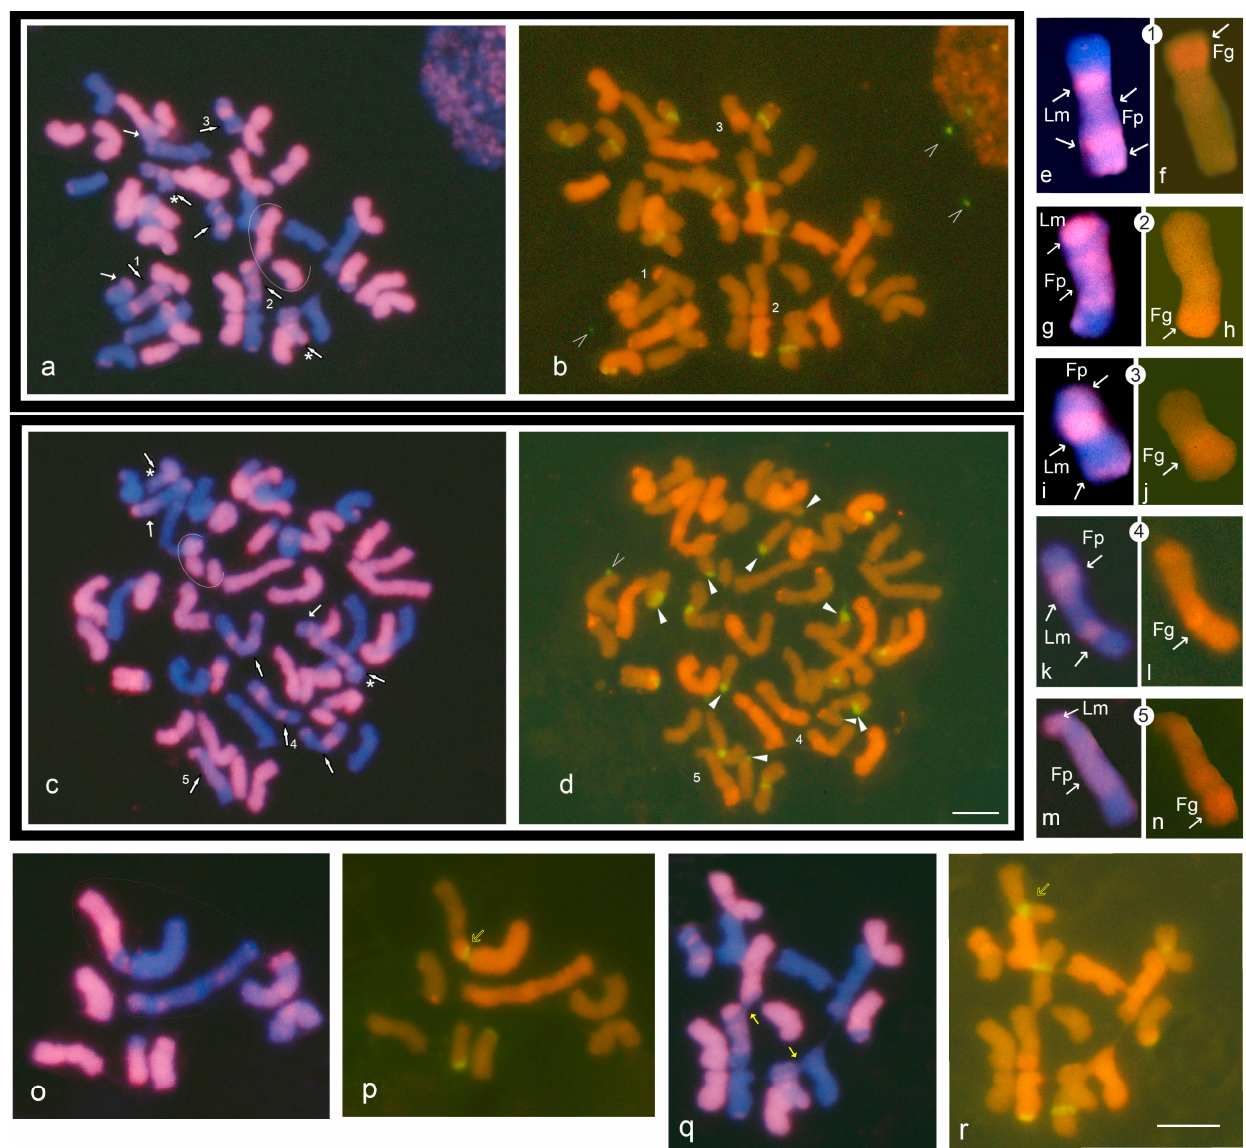
Figure 4. GISH/FISH in metaphase plates of L . multiflorum × F . arundinacea F2 3-18 donor (2n = 6x = 42) plant. Images of two representative mitotic metaphase chromosome spreads, A1 ( a , b ) and A2 ( c , d ), probed in two ways: ( a , c ) L . multiflorum genomic DNA probe detects L . multiflorum chromo- somes and their segments in red and highlights F . pratensis in mauve, F . glaucescens is blue (DAPI); ( b , d ) metaphase spreads reprobed with genomic F . glaucescens DNA probe (orange) and 45S rDNA